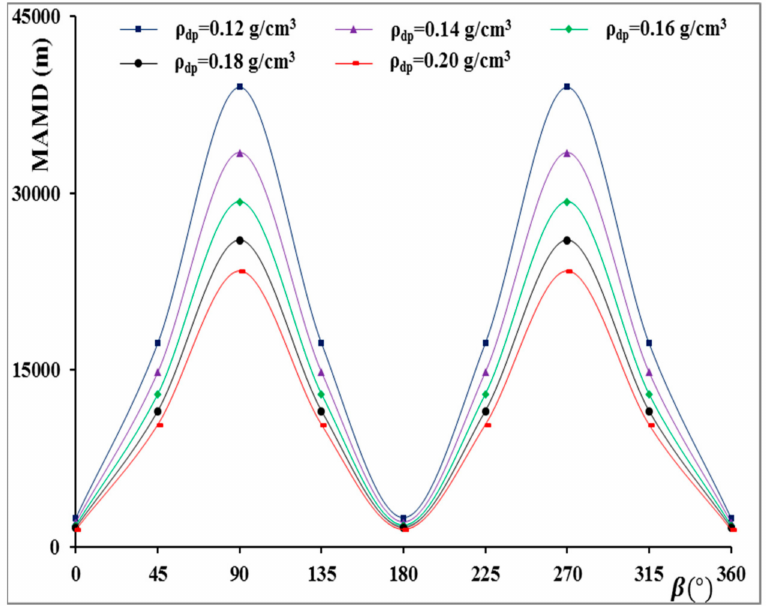
Figure 7. MAMD with ∆ p p / p p =